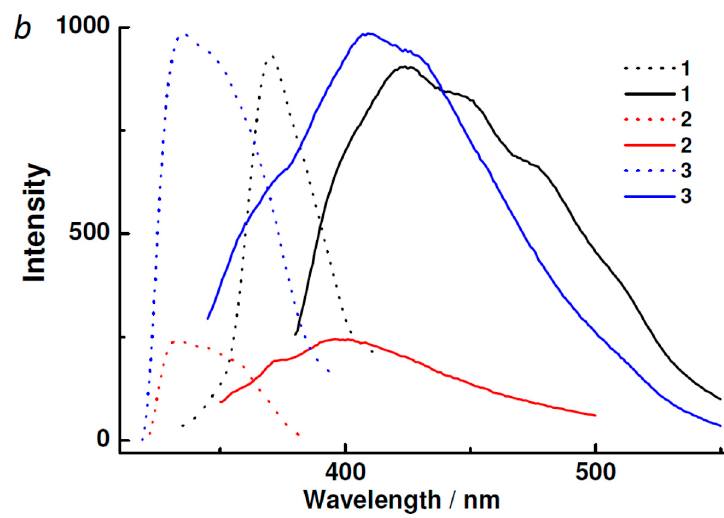
Figure 5. ( a ) UV-vis absorption spectra of 1 – 3 in ethanol solution; ( b ) Excitation (dotted line) and emission (solid lines) spectra of compound 1 – 3 in ethanol solution.